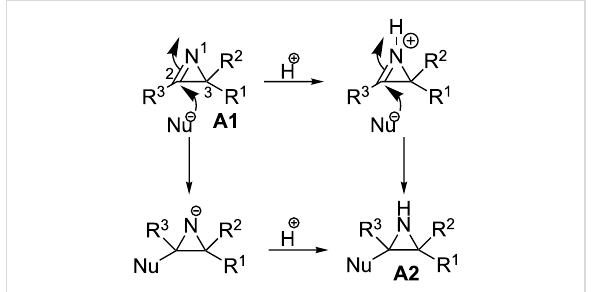
Figure 1: Formation of substituted aziridine.